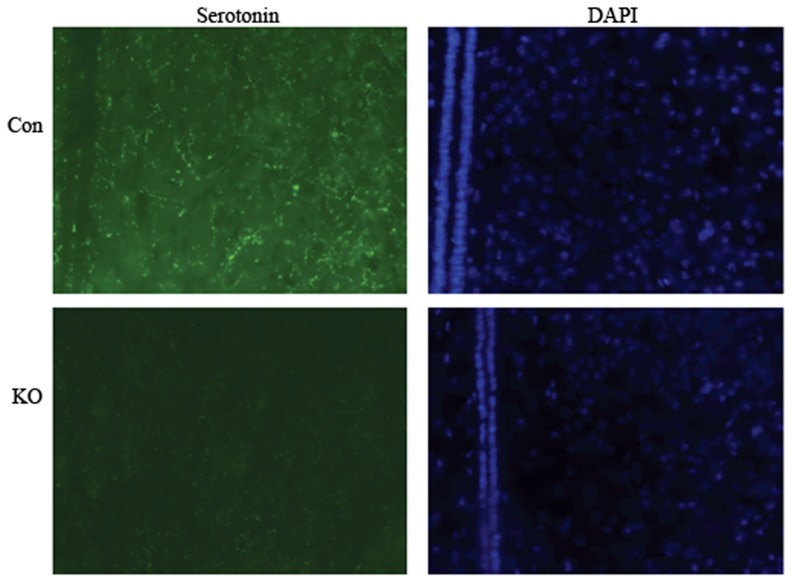
Fluorescent staining showed the decrease of serotonin in control and Ahi1 KO mice.The brain slices were stained with anti-serotonin antibody and DAPI. Significant decrease of fluorescent density of serotonin was observed in the hypothalamus area in Ahi1 KO mice (200X).